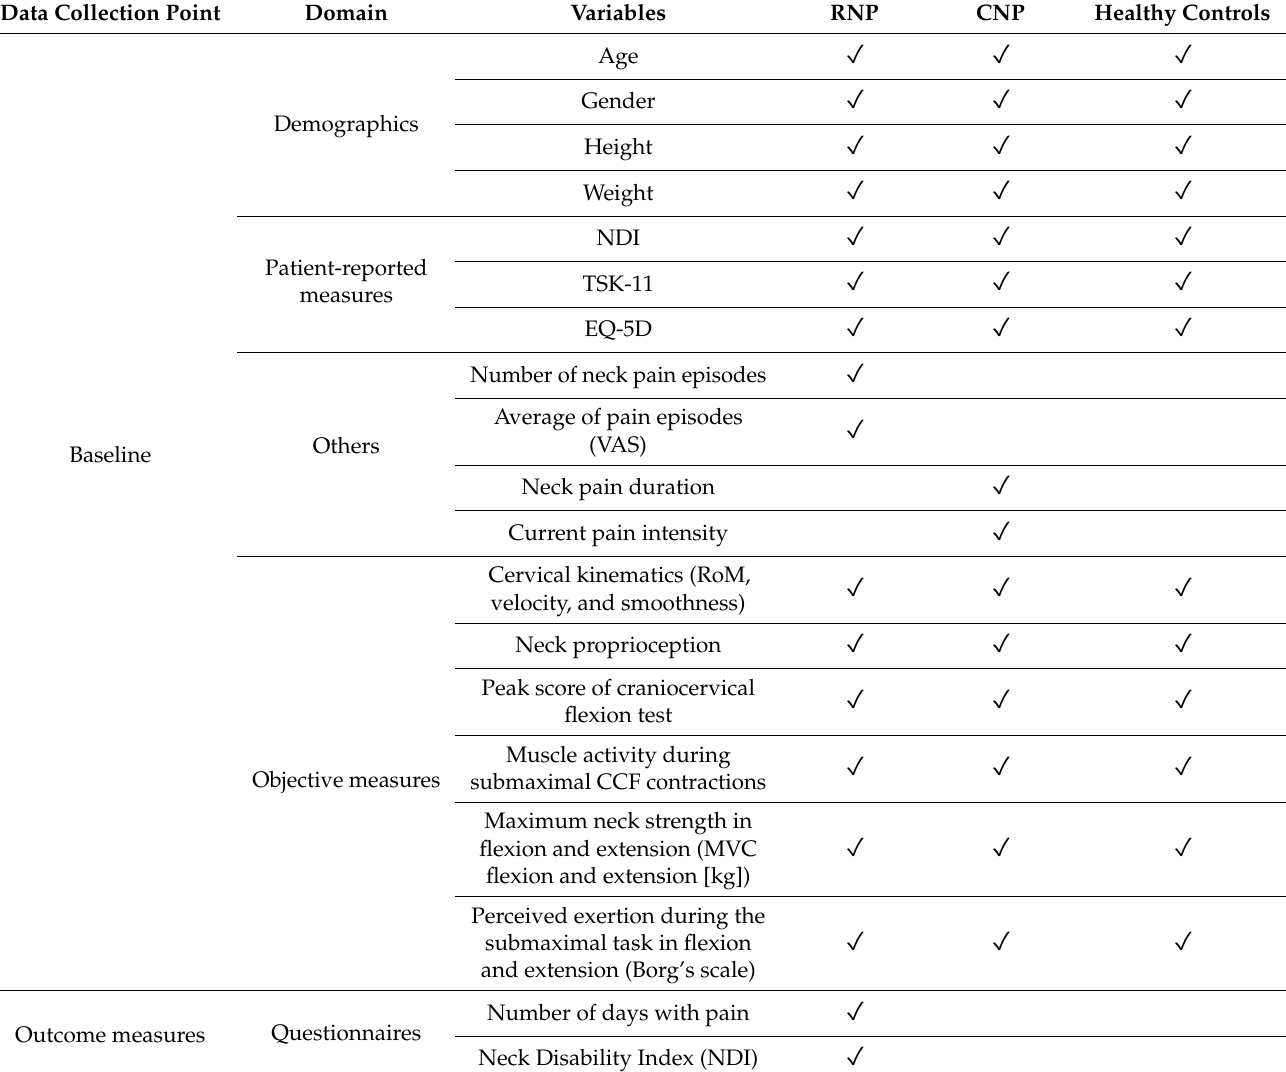
Table 1. Summary of collected data across groups and their time points.